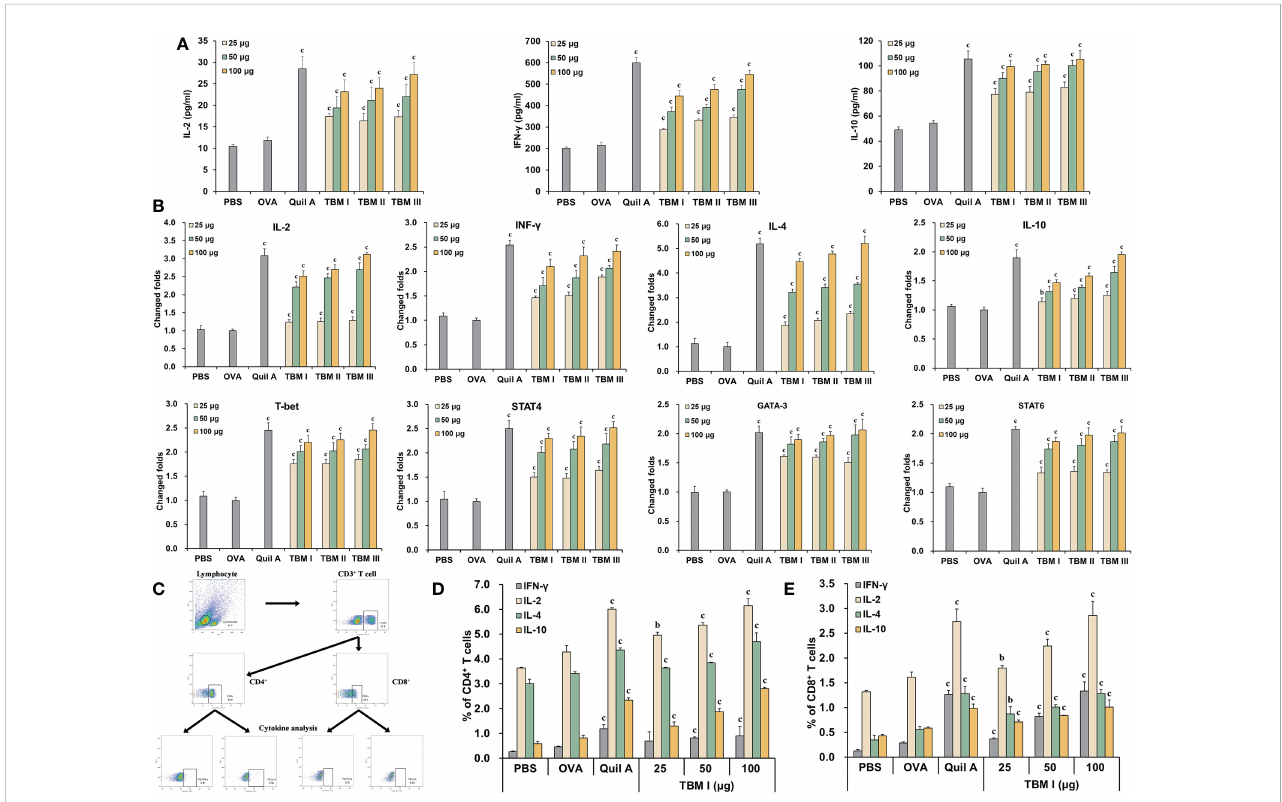
FIGURE 3 TBM I elicited both Th1/Th2 and Tc1/Tc2 responses towards OVA in mice. Splenocyte and culture supernatants were collected 72 h after stimulation with OVA. (A) The contents of cytokines in culture supernatants using ELISA kits. (B) The mRNA expression levels of cytokines and TFs in OVA-stimulated splenocytes by RT-qPCR. (C – E) Splenocytes were subjected to fl ow cytometry for measuring OVA-speci fi c T cell cytokine response. (C) Schematic diagram of gating on IFN- g + and IL-4 + CD3 + CD4 + and CD3 + CD8 + T cells. Frequencies of OVA-speci fi c CD4 (D) and CD8 (E) T cells expressing single cytokine. The data are presented as mean ± SD ( n = 5). b P < 0.01, and c P < 0.001 vs